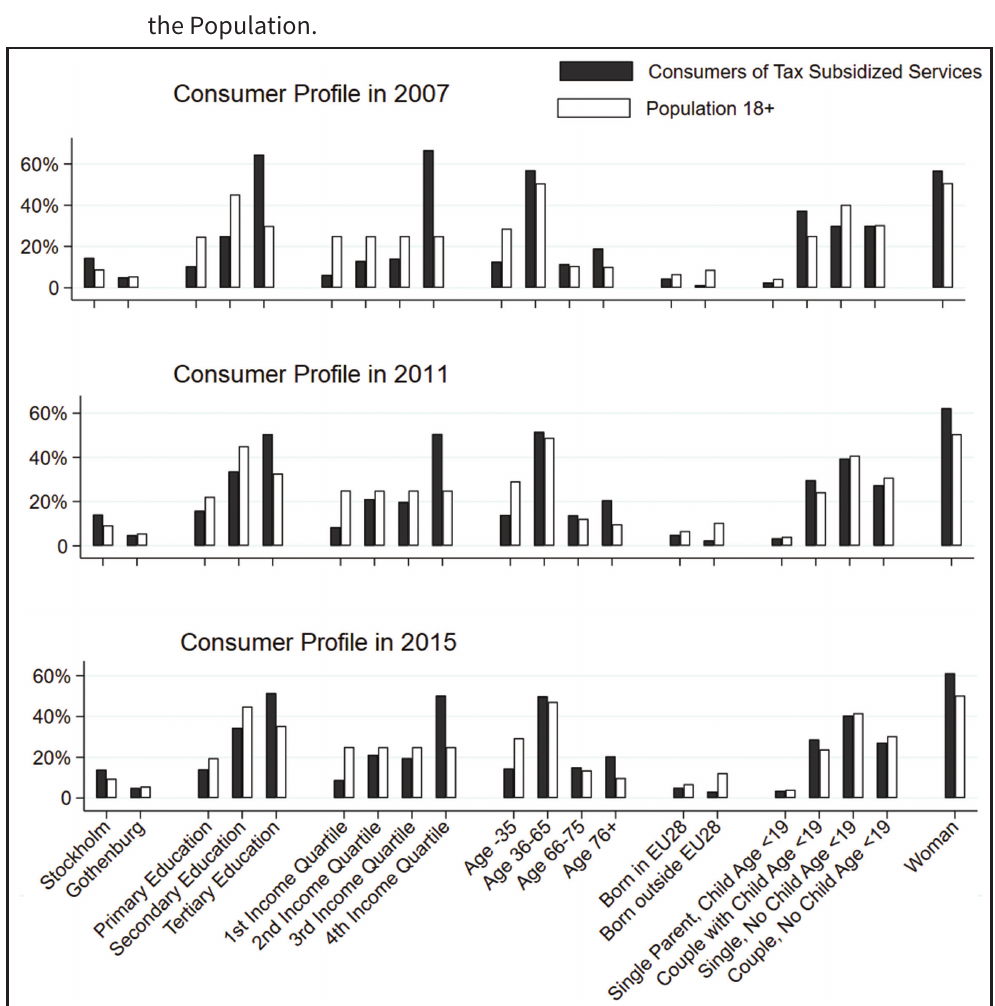
Figure W2 Demographic Profile of Consumers of Subsidized Services Compared to the